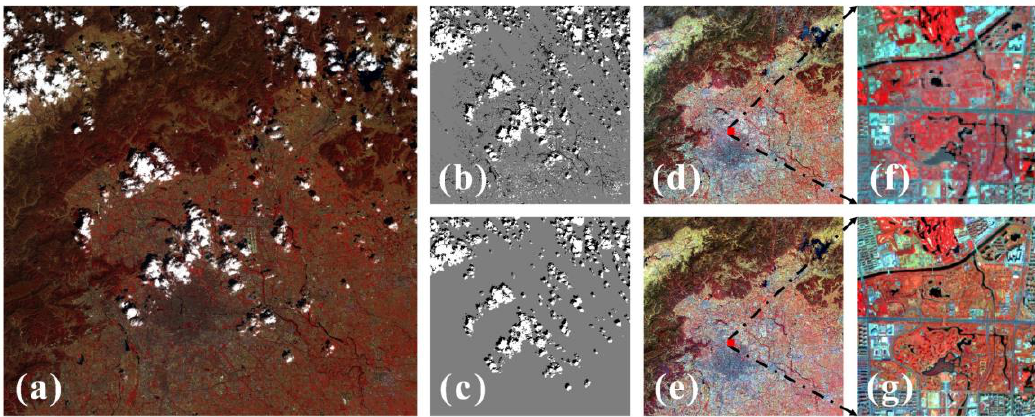
Figure 3. An example of generating fused 10 m image (18 April 2016): ( a ) raw Landsat-8 image (30 m); ( b ) cloud and cloud shadow detection by ATSA; ( c ) cloud mask after manual correction; ( d ) cloud removal by NSPI; ( e ) fusion with Sentinel-2 images by ESTARFM (10 m), ( f ) and ( g ) zoom-in sub-image marked by a red frame in (d) and (e).